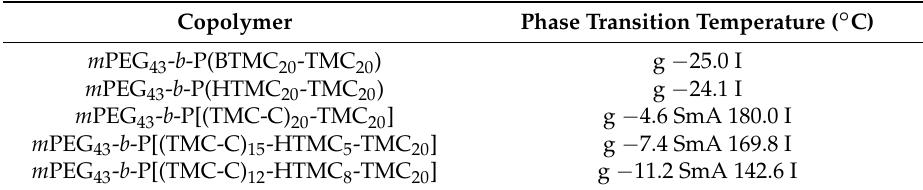
Table 3. Thermal properties of the